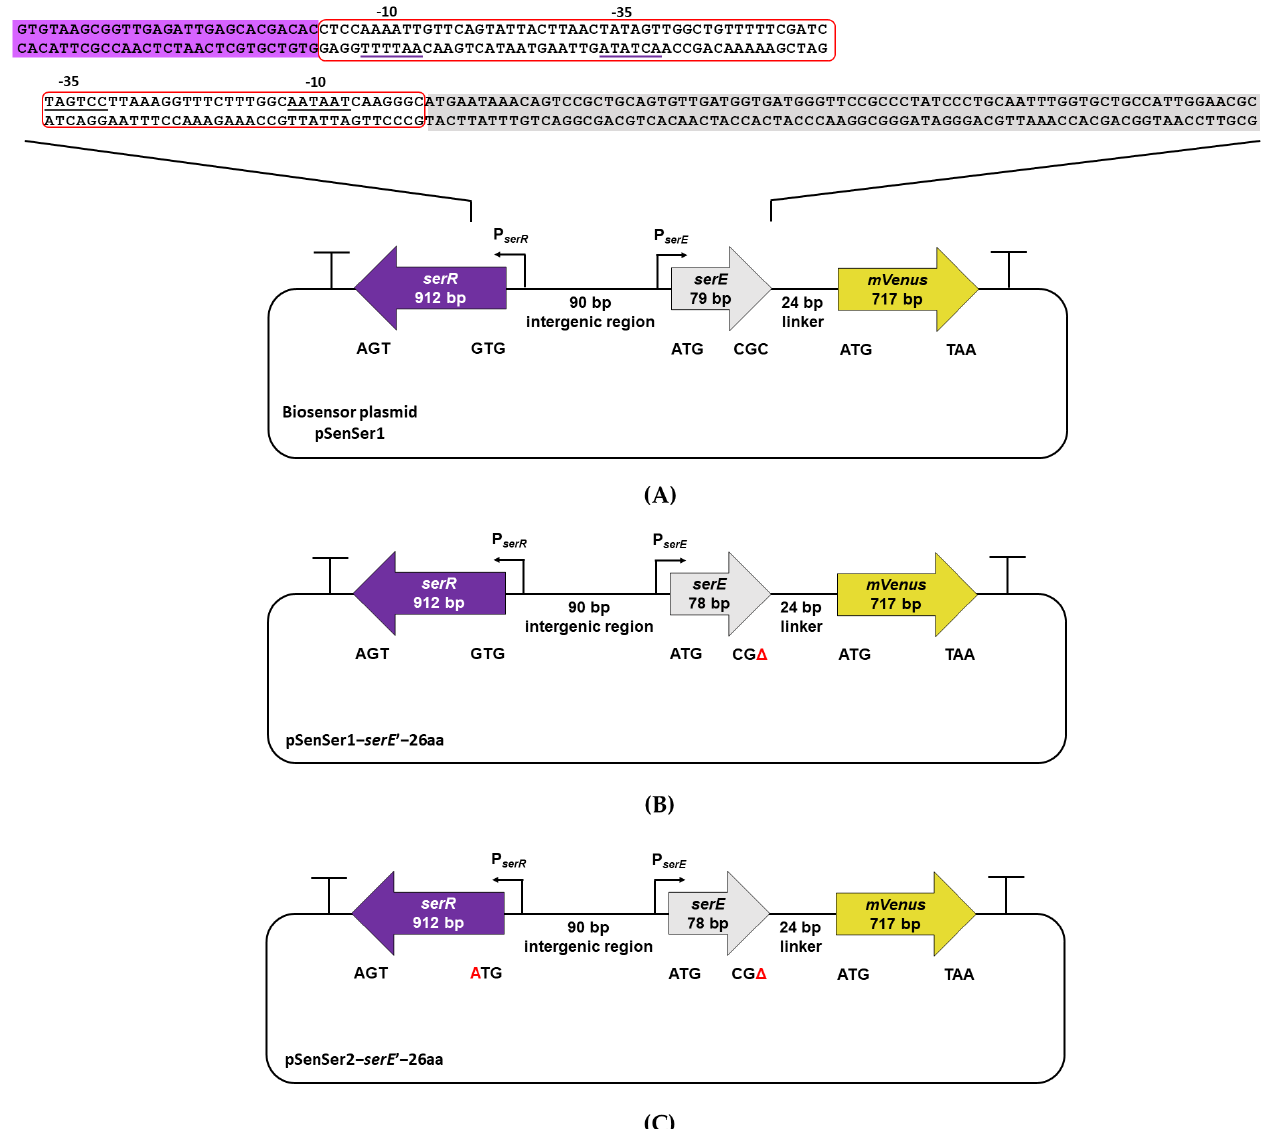
Figure 1. Schematic representation of L -serine biosensor components. ( A ) The transcriptional activa- tor SerR (gene in violet) is expressed from its native promoter (P serR ). SerR activates the expression of the promoter of serE (in gray) at elevated intracellular L -serine concentrations. The intergenic region between serR and serE (boxed in red) and the putative − 10 and − 35 regulatory sequence are labeled and underlined. ( B ) pSenSer1- serE ’-26aa with a nucleotide deletion leading to shortened SerE peptide and ( C ) pSenSer2- serE ’-26aa replacing the translational start codon of serR from GTG to the canonical ATG.